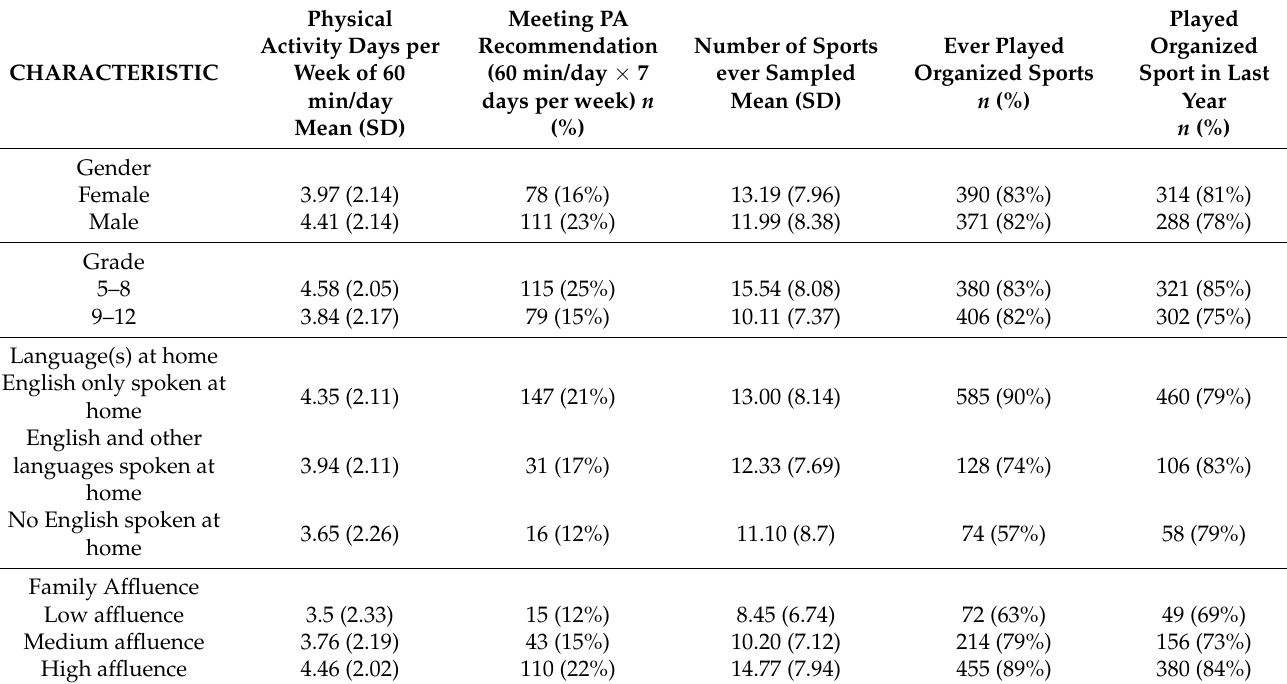
Table 2. Physical activity and sports participation by demographic and socioeconomic